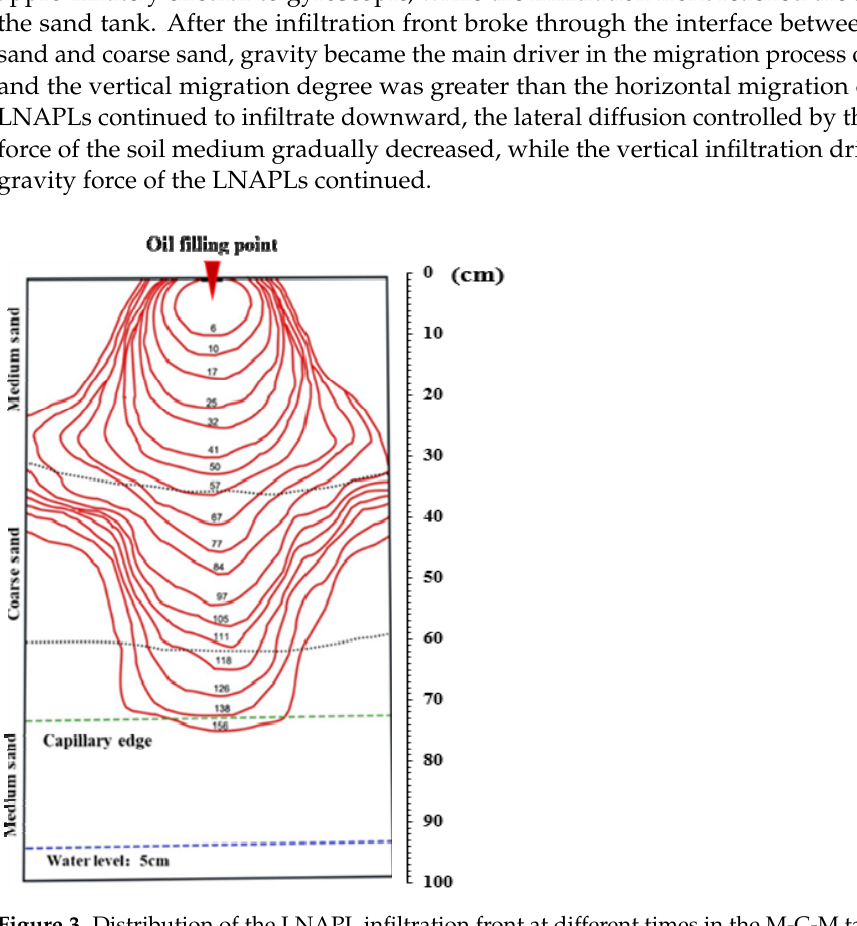
Figure 3. Distribution of the LNAPL infiltration front at different times in the M-C-M tank.